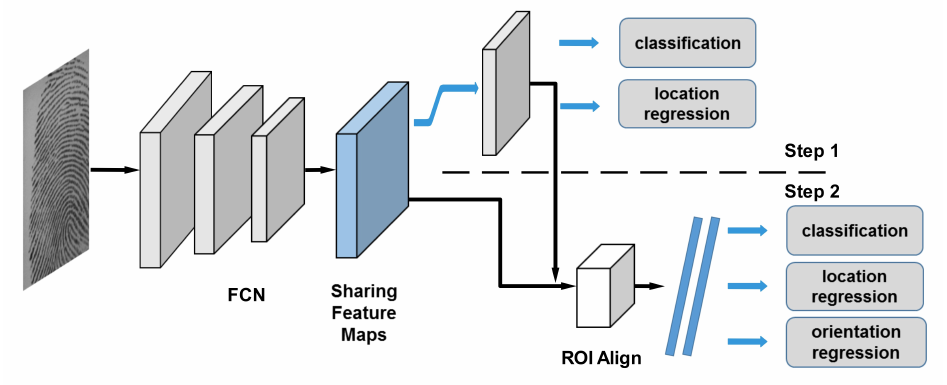
Figure 2. The overall flowchart of our proposed method. Each thin rectangle denotes a fully-connected